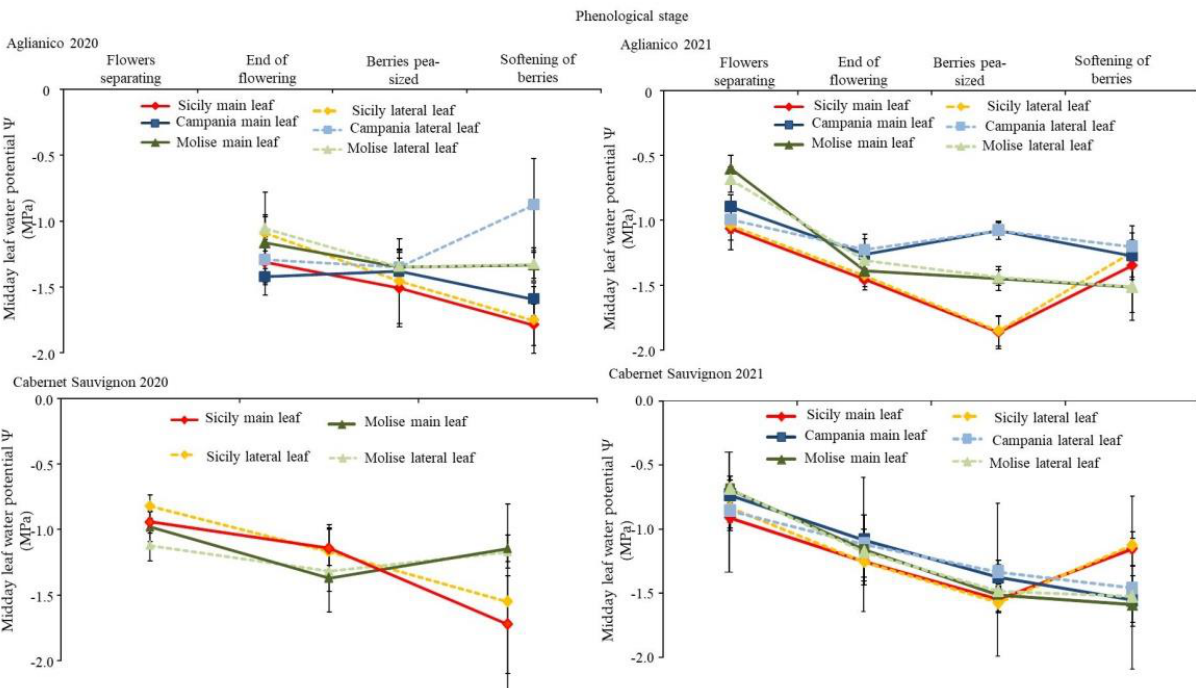
Figure 7. Midday leaf water potentials measured on main and lateral leaves recorded in each of two cultivars, Aglianico (AGL) and Cabernet Sauvignon (CAB), grown in three different sites, Molise (MOL), Campania (CAM), and Sicily (SIC). Measurements were made at the phenological stages BBCH57 (only second year) flowers separating, BBCH69 end of flowering, BBCH75 berries pea-sized, and BBCH85 softening of berries (bars indicate one standard deviation), based on Tukey’s HSD test within sites and years.